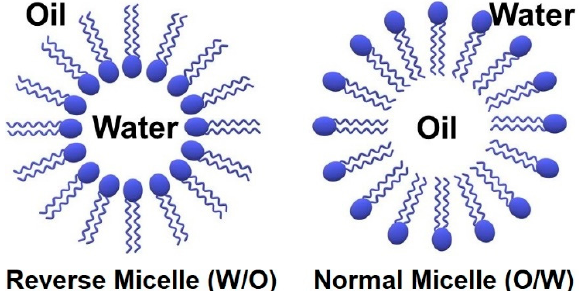
Figure 2. Schematic structure of a reverse and normal micelle.